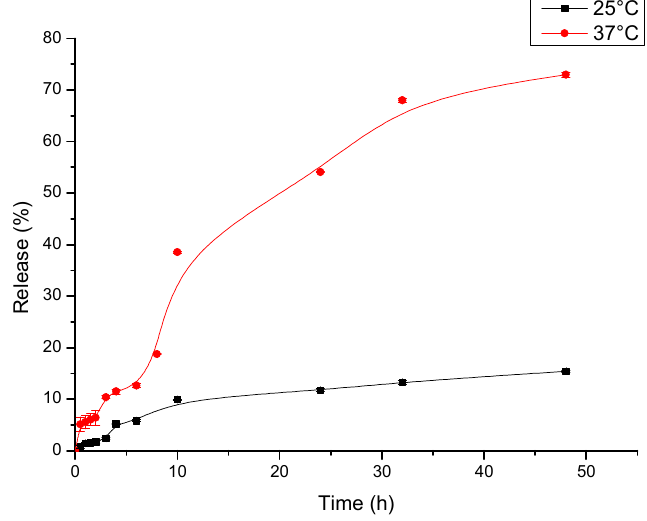
Figure 9. Drug release profiles of Ni-NP PVA gel in water.